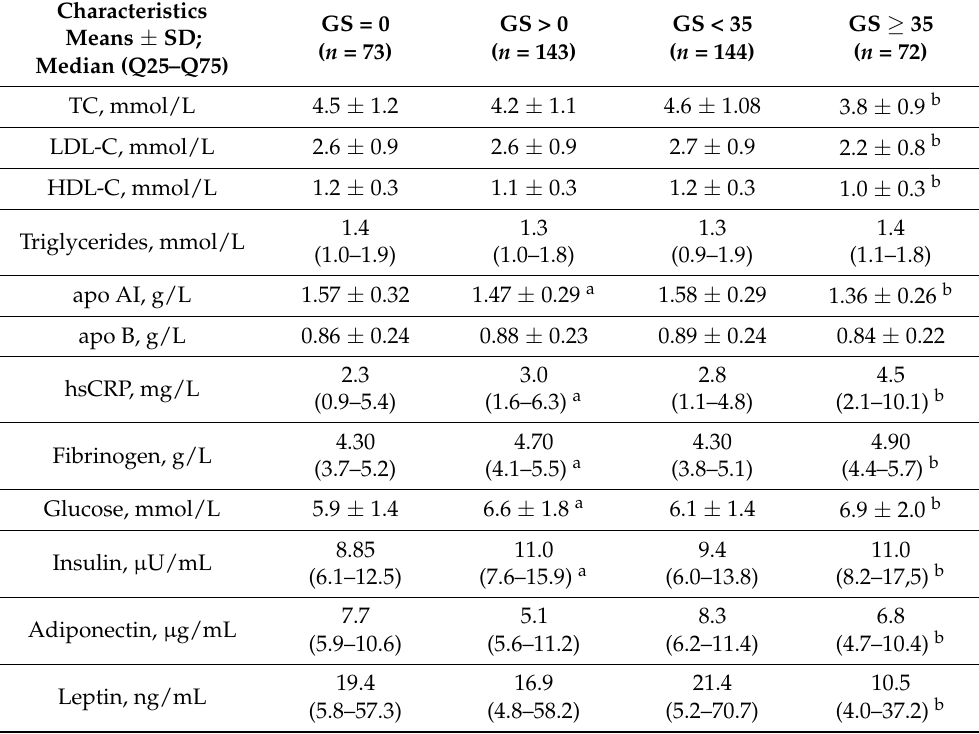
Table 3. Circulating biochemical parameters of the patients from the tested cohort. Characteristics